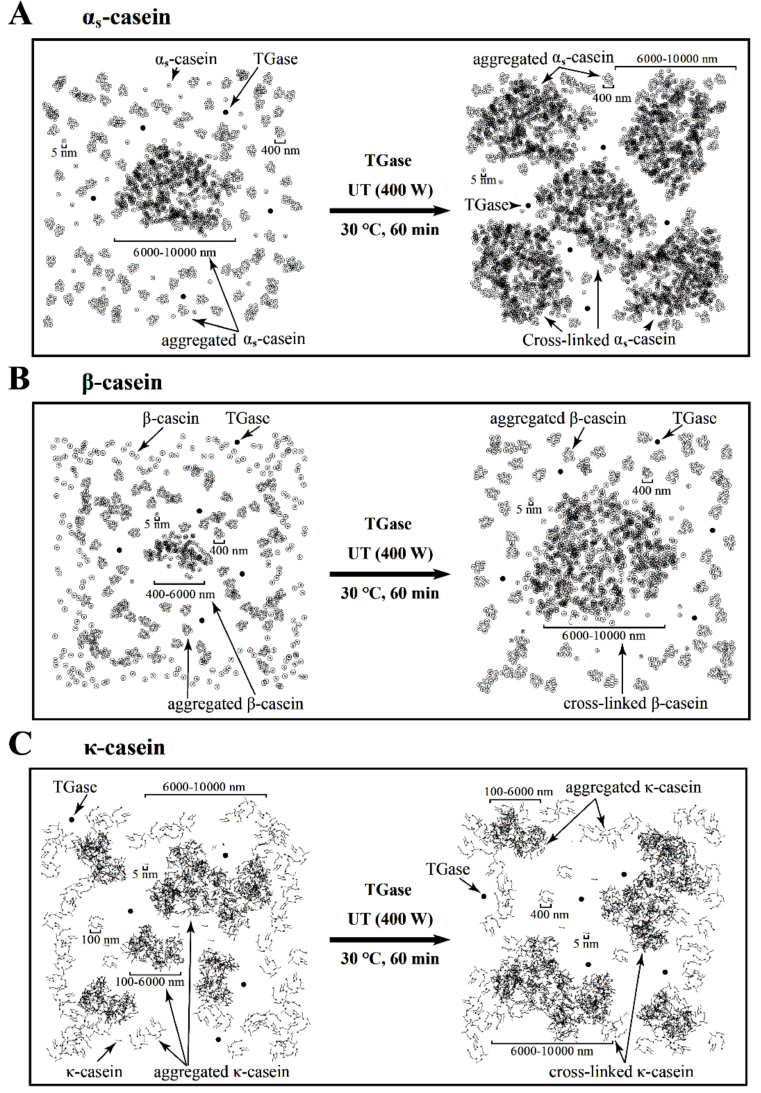
Figure 7. Reaction scheme for the TGase and UT on the polymerization of individual α s -CN, β -CN and κ -CN induced by TGase and UT. ( A ) α s -CN, ( B ) β -C, and ( C ) κ